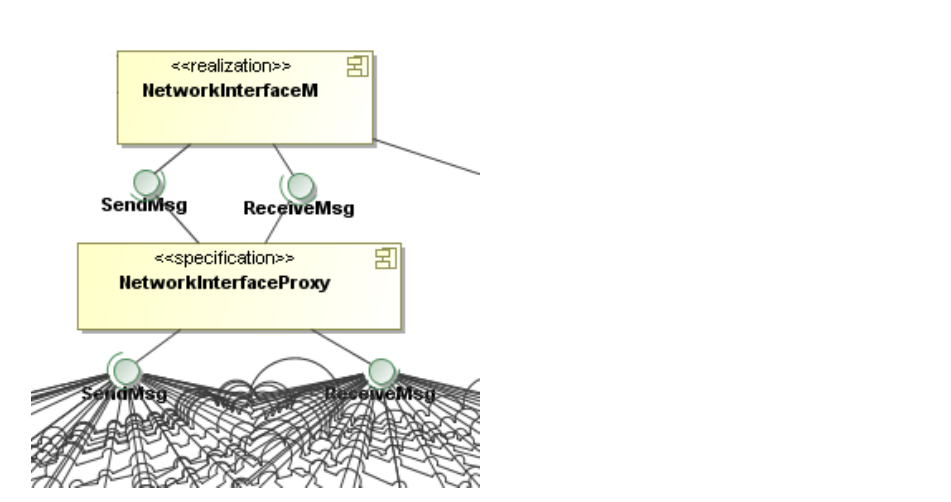
Figure 7. Agilla NetworkInterfaceM and NetworkInterfaceProxy components